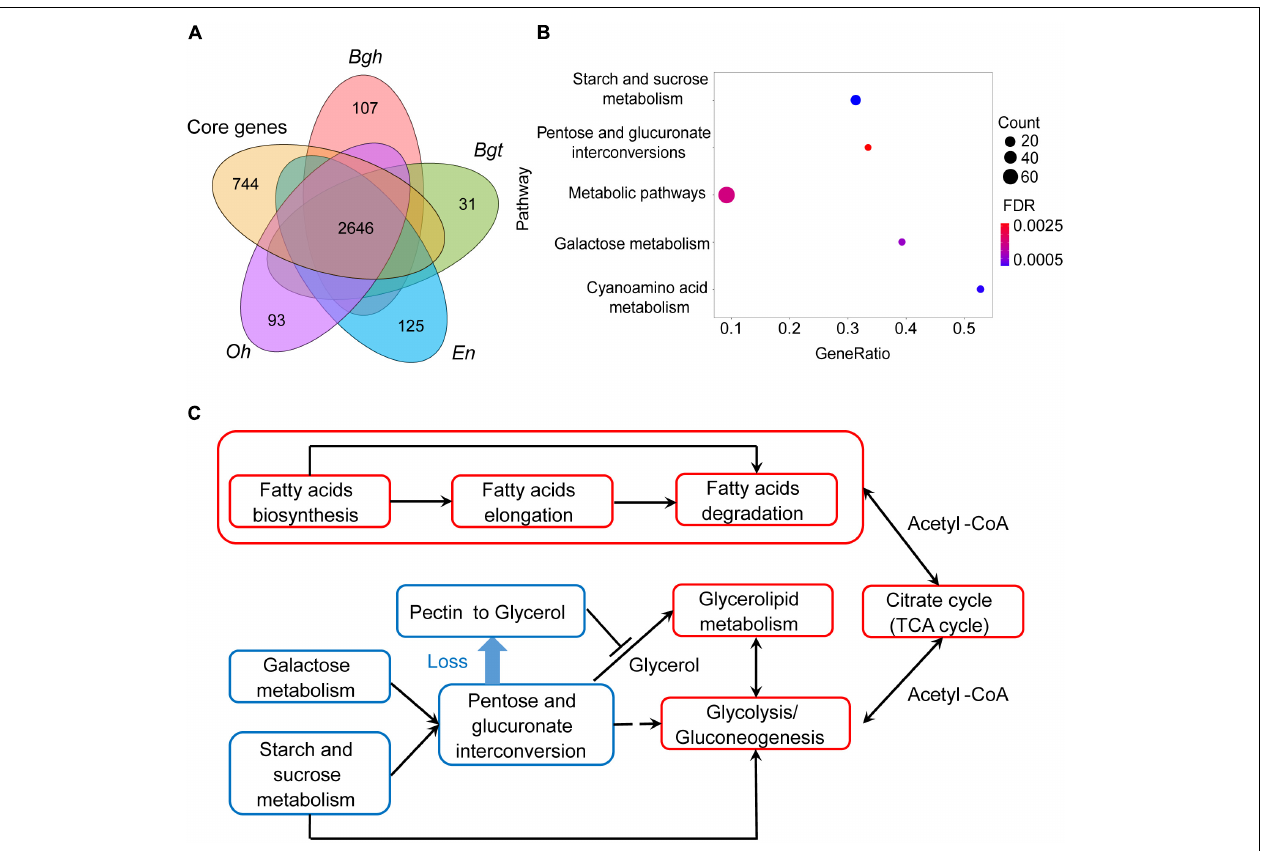
FIGURE 2 | Powdery mildews’ MACGs enrich for the carbohydrate-related metabolism pathway and conserved core genes enrich for the lipid-related metabolism pathway. (A) Comparison of orthologous genes between powdery mildews and ascomycete pathogen core genes. The core genes represent the common gene families shared by five ascomycete pathogens, including Magnaporthe oryzae , Colletotrichum higginsianum , Fusarium graminearum , Botrytis cinerea, and Sclerotinia sclerotiorum . Numbers indicate conserved families and species-specific families. Conserved core genes contain 2,646 orthologous families. The MACGs contain 744 orthologous families. (B) MACGs enrich for the carbohydrate-related metabolic pathway. The size of the dot indicates the number of genes associated with MACG pathways. Statistical analyses used the false discovery rate (FDR < 0.05). (C) Powdery mildews employ carbohydrate metabolism-related pathways and maintained lipid metabolism-related pathways. The red frames indicate integrated pathways. The blue frames indicate contractive pathways. Solid lines indicate direct relationships between pathways. Dashed lines indicate multiple steps in the